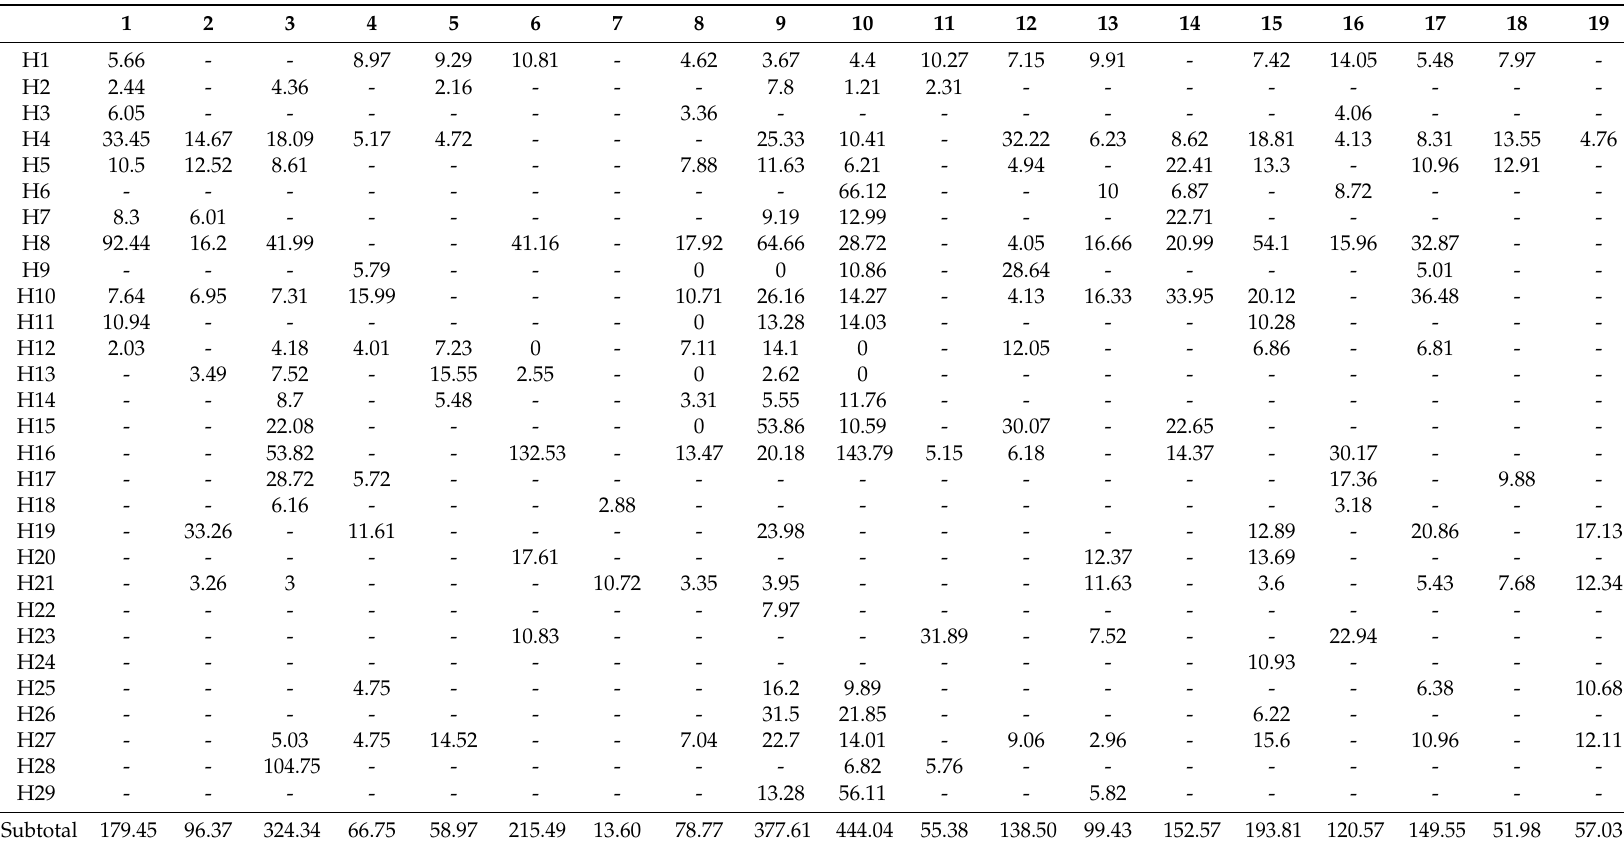
Table 4. Concentrations ( µ g/kg fresh weight (FW) equivalent of nonyl acetate) of volatile non-terpene hydrocarbons in 37 mango